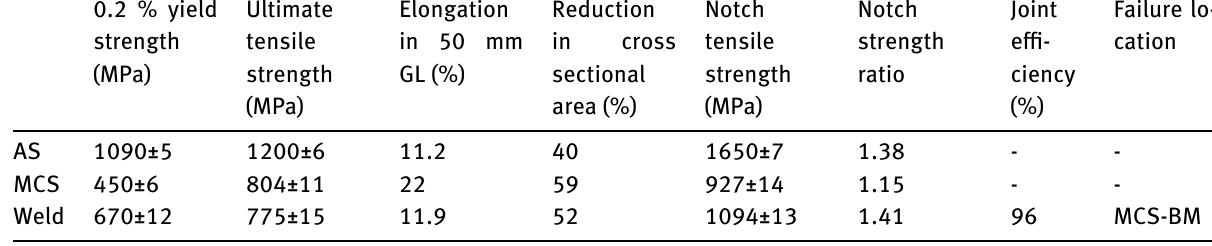
Table 3: Tensile properties of base metals and dissimilar joint. 0.2 % yield